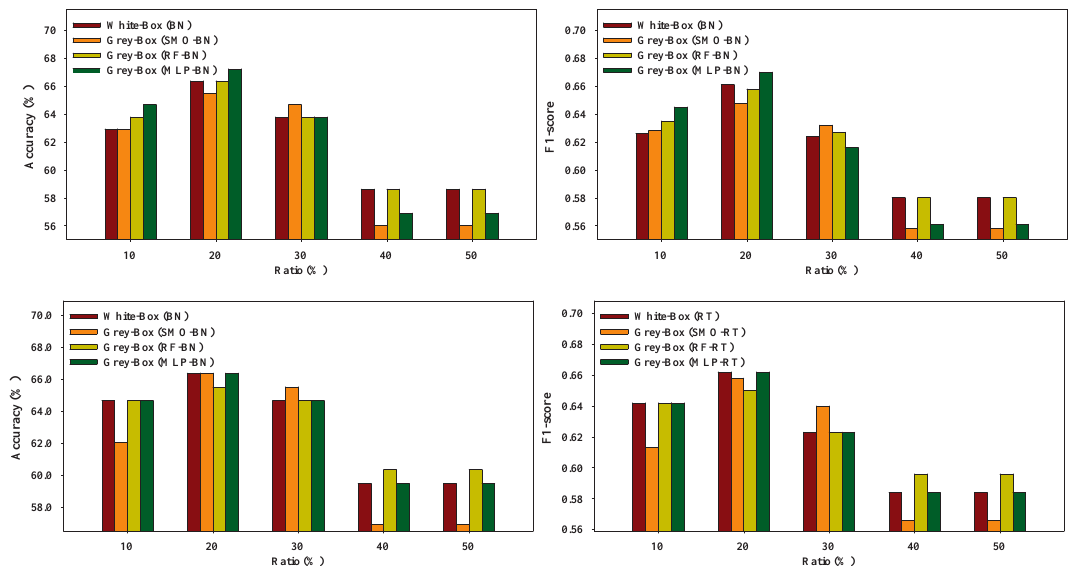
Figure 7. Box-plot with performance evaluation of Grey-Box and White-Box models for Coimbra dataset.